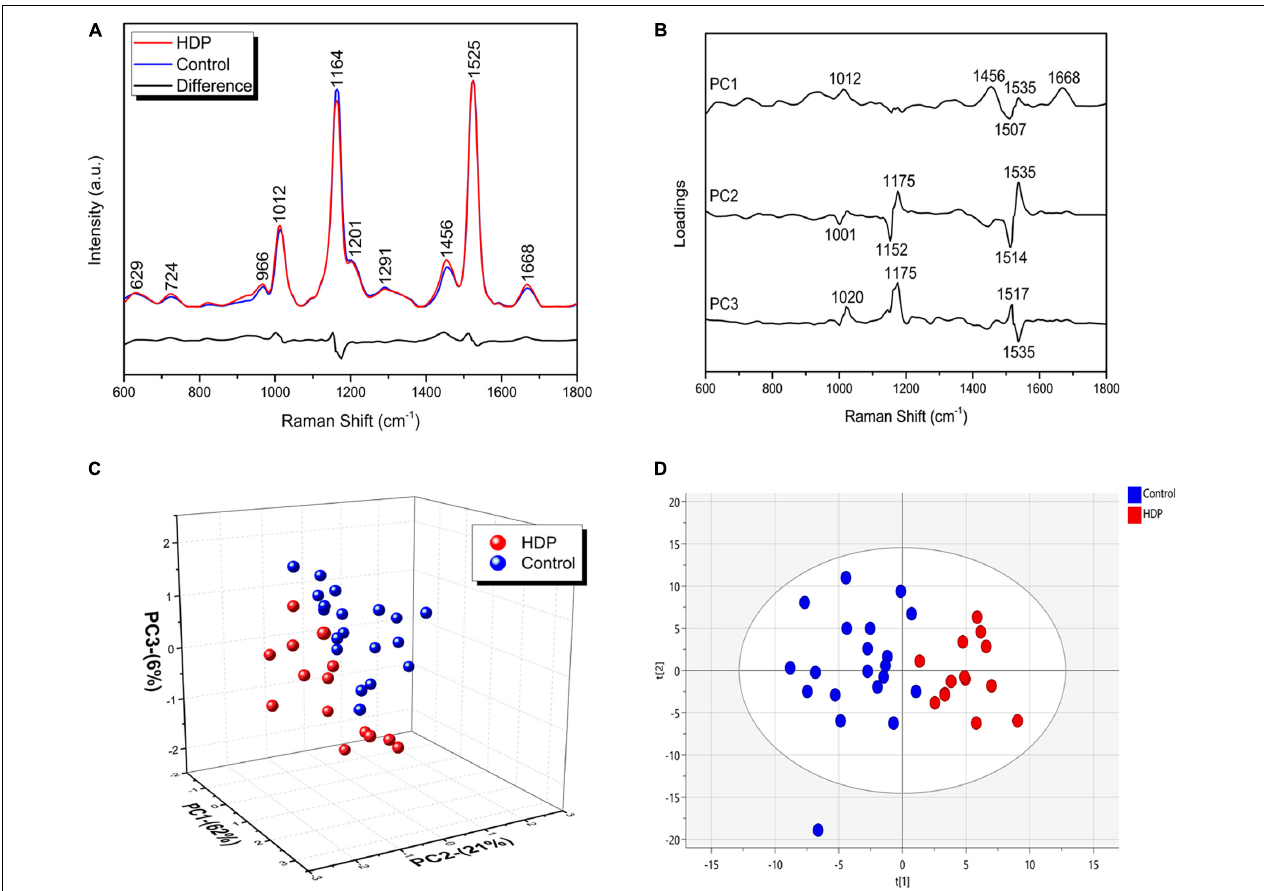
FIGURE 2 | HDP changes the exosome-enriched plasma biochemical signature. (A) The Raman spectra represent the averages of five spectra captured from each sample of both groups (Control and HDP) in the fingerprint region (600–1,800 cm − 1 ). Main Raman spectra from control and HDP with the most variable bands; (B) Loadings of PC1, PC2, and PC3 for Control and HDP; (C) Three-dimensional PCA score plot. (D) Two-dimensional OPLS-DA score plot of the Raman spectra for the control and HDP groups. The two groups were relatively well discriminated along t[1] axis, as well along t[2] axis.